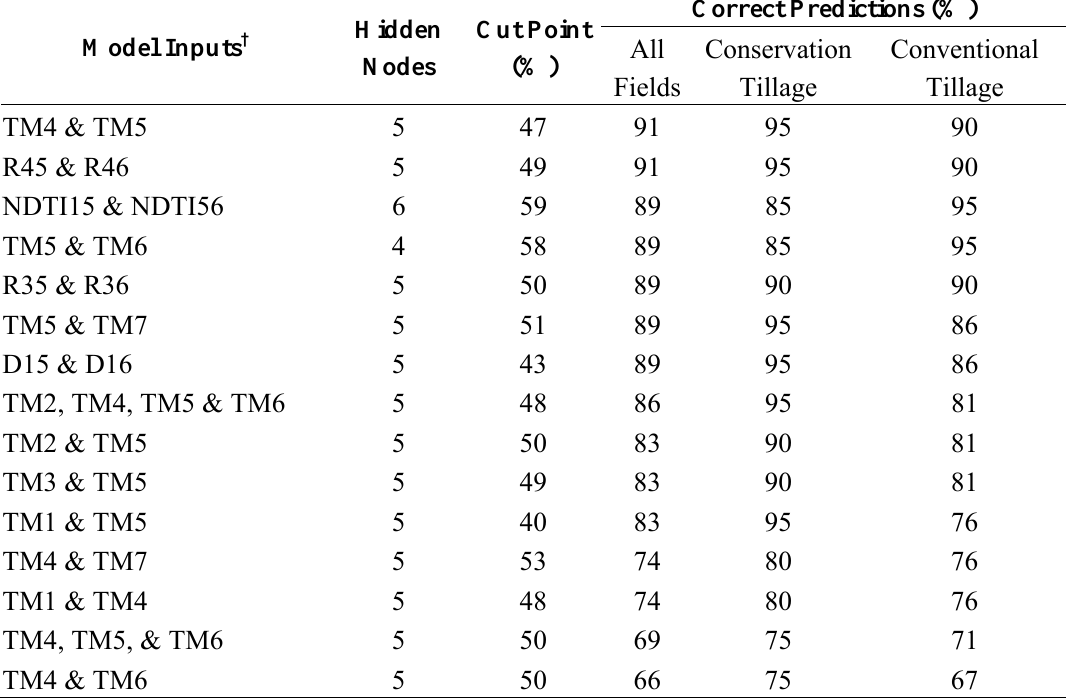
Table 3 . Landsat TM based ANN models’ performance for mapping tillage practices in Moore County, Texas. Model Inputs †